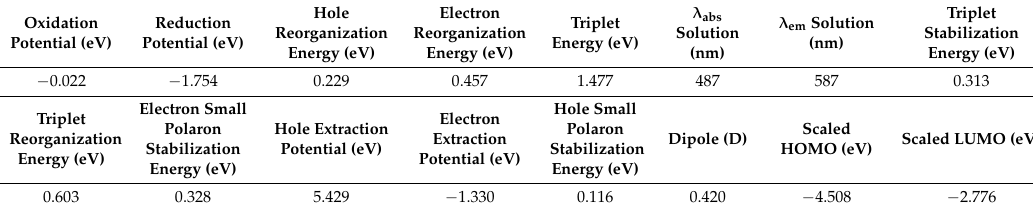
Table 2. Calculated electro-optical parameters for